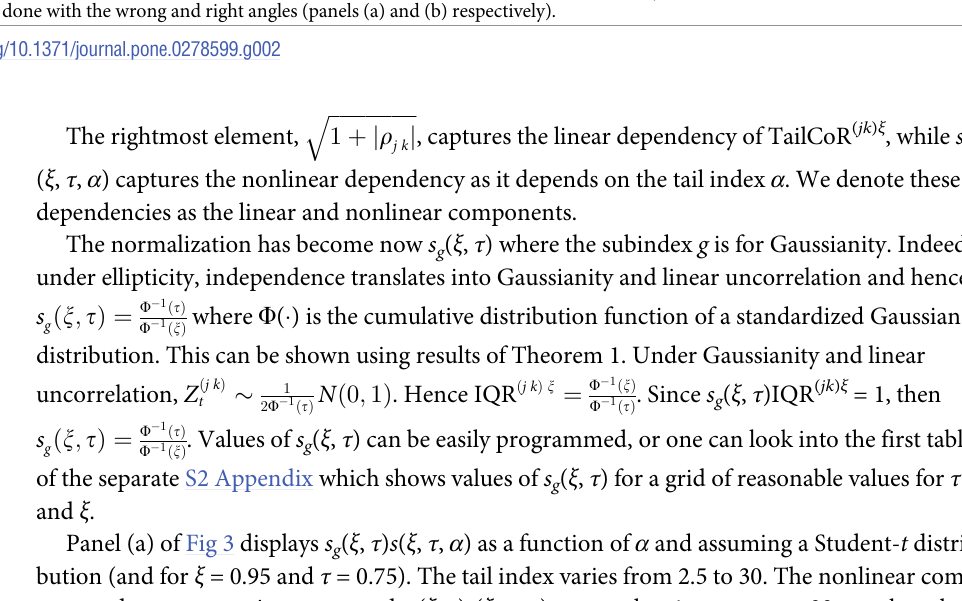
and X are negatively related and the j k